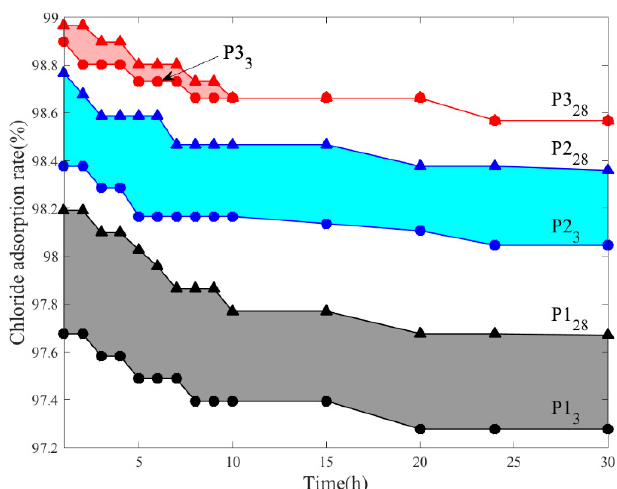
Figure 5. The chloride adsorption ratio of P1, P2, and P3 at 3d and 28d.